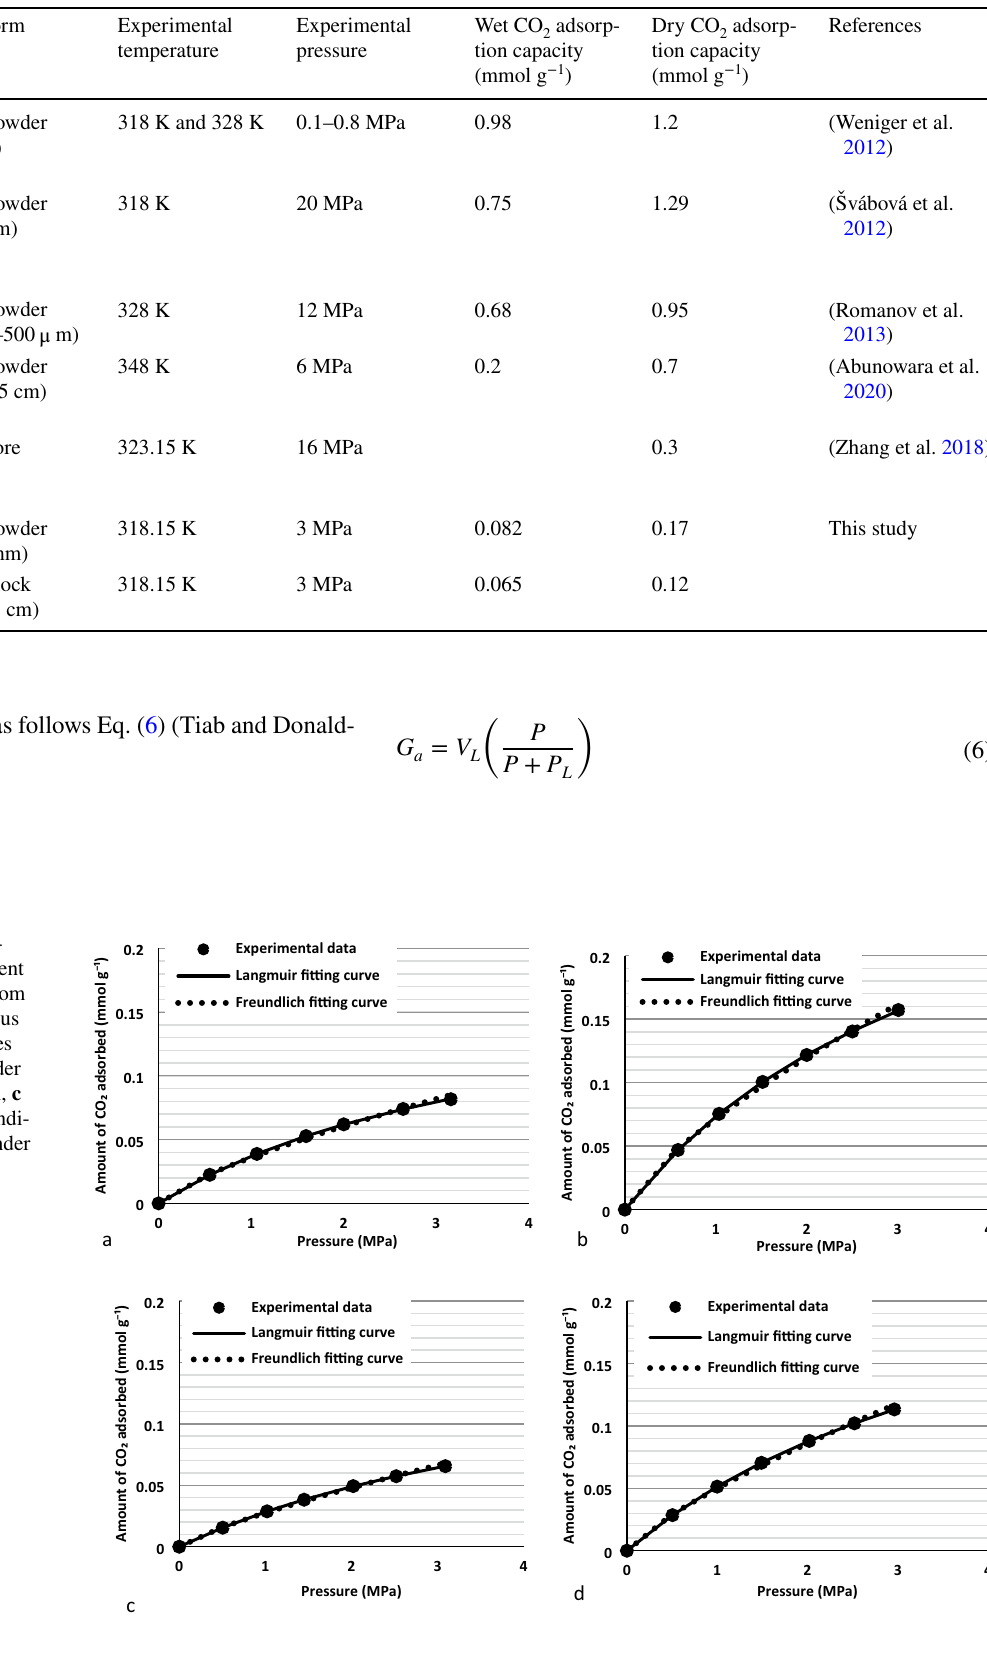
Table 3 Summary of the CO 2 adsorption on low rank under various conditions